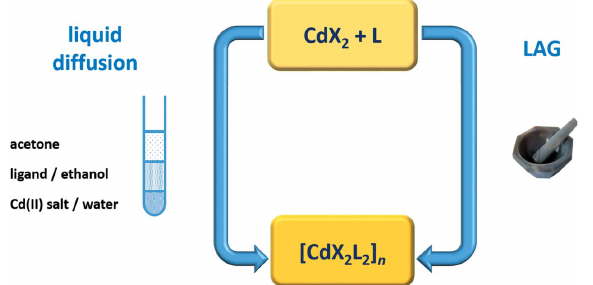
Figure 5 The synthetic pathways for complexes 1 – 9 . Both methods yield the exact same products, a polymeric [Cd X 2 L 2 ] n type of product ( X = Cl, Br, I; L = 2-pyz, 4-pym, 4-quz) for 1 – 8 , and a monomeric complex [CdI 2 (4-quz) 2 ] for 9 .